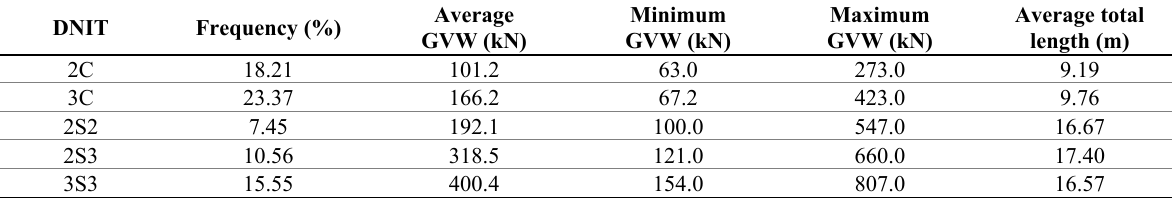
Table 3. Statistics for main classes of BR-290 (adapted from Portela